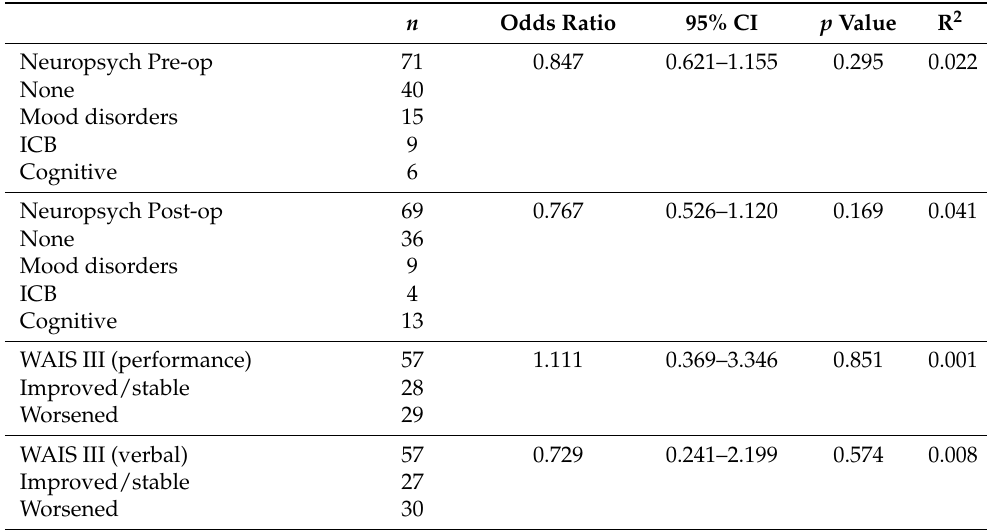
Table 4. Univariate regression results of the potential neuropsychological risk factors influencing driving post